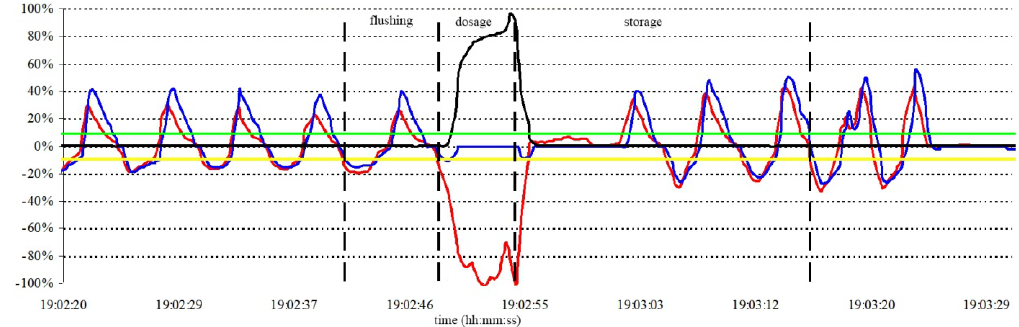
Figure 4. Time dependence of the respiration process during the lung imaging procedure. Respiration pressure (y * 20 mbar), respiration flow (y * 2 dm 3 / s), helium pressure (y * 150 mbar), inhalation threshold (y * 20 mbar), and exhalation threshold (y * 20 mbar) are shown in red, blue, black, green, and yellow,